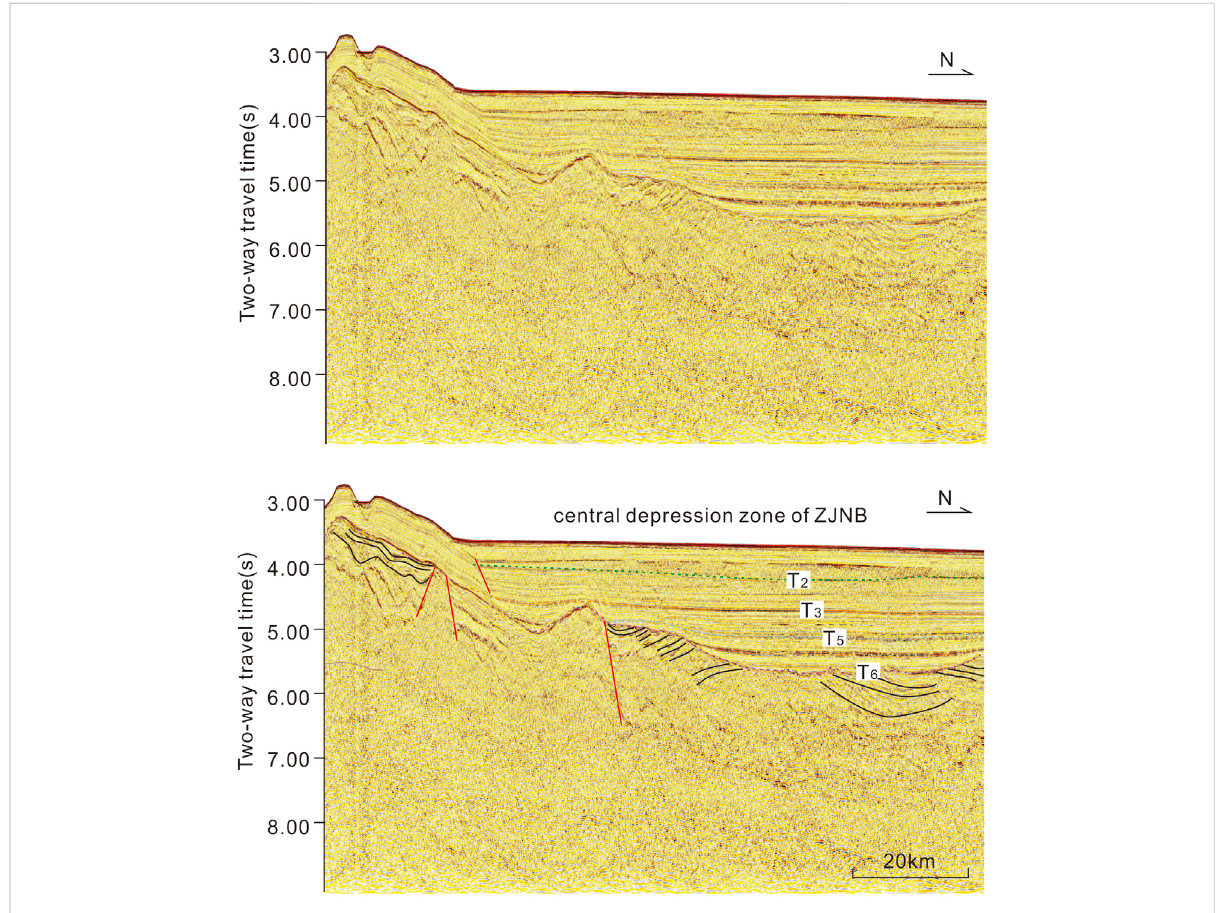
FIGURE 3 Sedimentary-structure development characteristics in the central Zhongjiannan Basin (See line A2 in Figure 1 for pro fi le